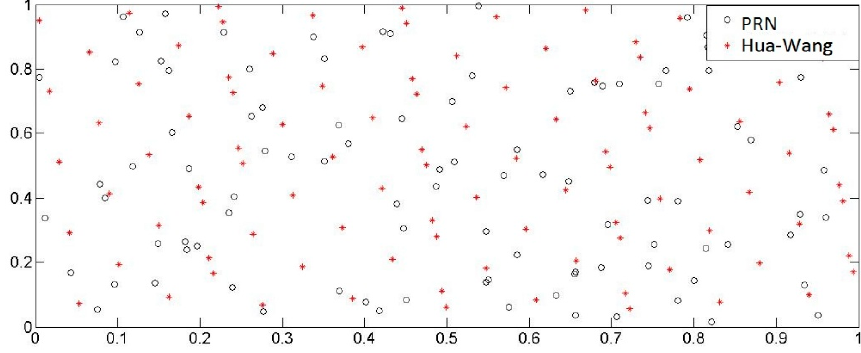
Figure 9. Distribution of 100 sample points generated by the two methods.